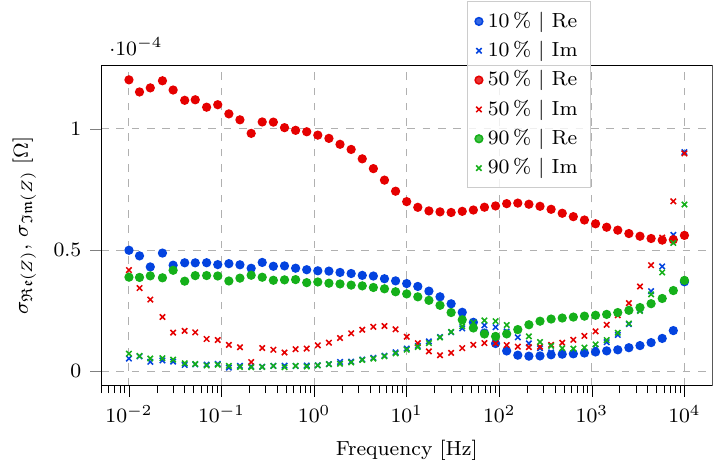
Figure 8. Impedance’s standard deviation in different storage SoC and same temperature ( 45°C ) conditions. Legend shows the storage SoC.